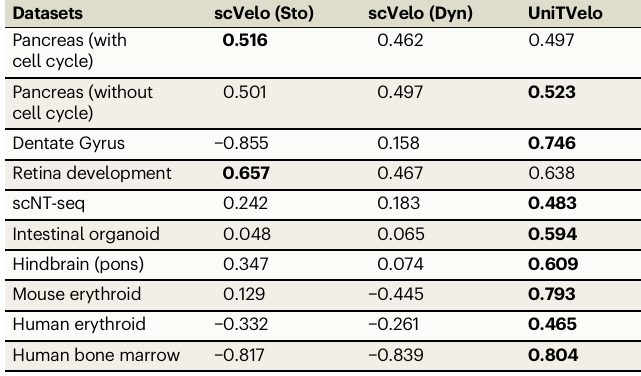
Cross-boundaryDirection Correctness(CBDir) is used toevaluate the transitioncorrectness givengroundtruth,seeMethods.Thebestperformanceineachmetricishighlightedinboldfont. Sto: scVelo ’ s stochastic mode. Dyn scVelo ’ s